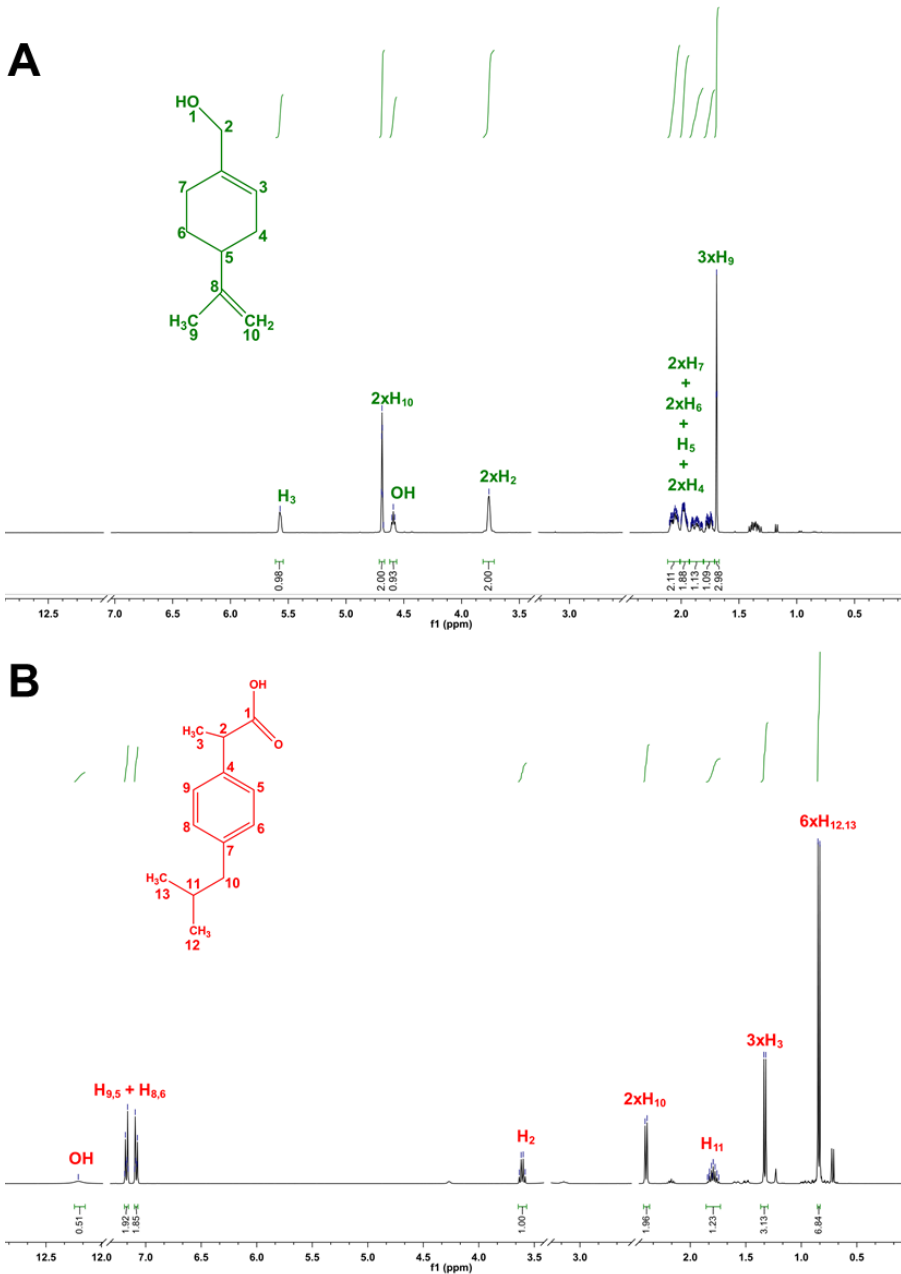
Figure 3. 1H NMR spectra of ( A ) POH and ( B ) IBU. Peak assignment and integration were fully performed.